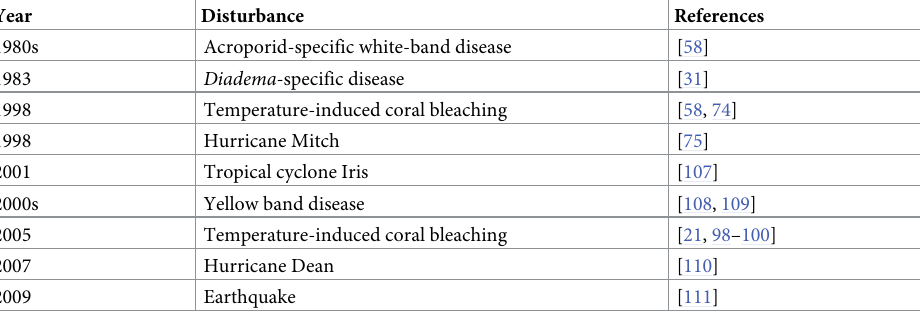
Table 1. Timeline of major disturbances to the Belizean Barrier